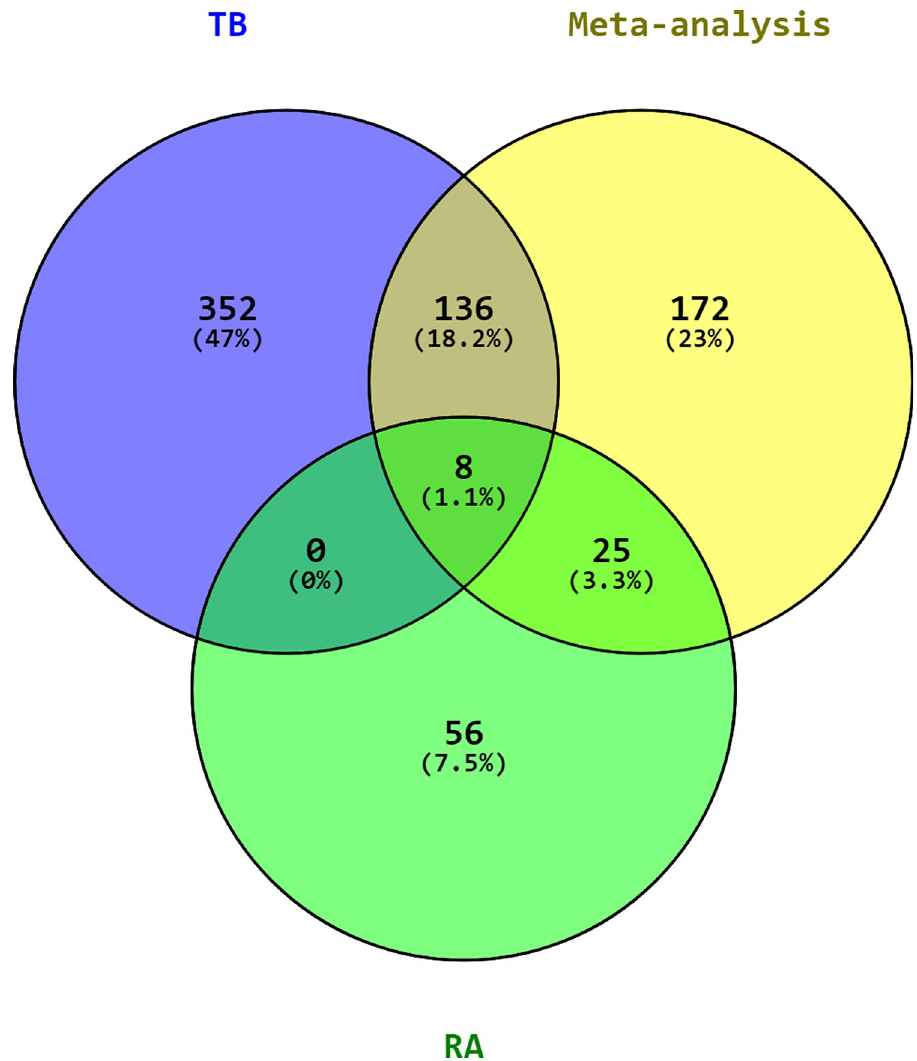
Fig 1. Venn diagram of DEGs. In comparison to the individual meta-analysis of the Tuberculosis (TB) and rheumatoid arthritis (RA) datasets, the combined meta-analysis of both diseases shows many DEGs (172) that only were significantly different following this approach. Loss of genes that were only significant in their respective disease datasets (genes that play no role common to both conditions) is also expected. Data sets were analyzed with the same parameters in NetworkAnalyst, and genes with a p-value < 0.01 were considered